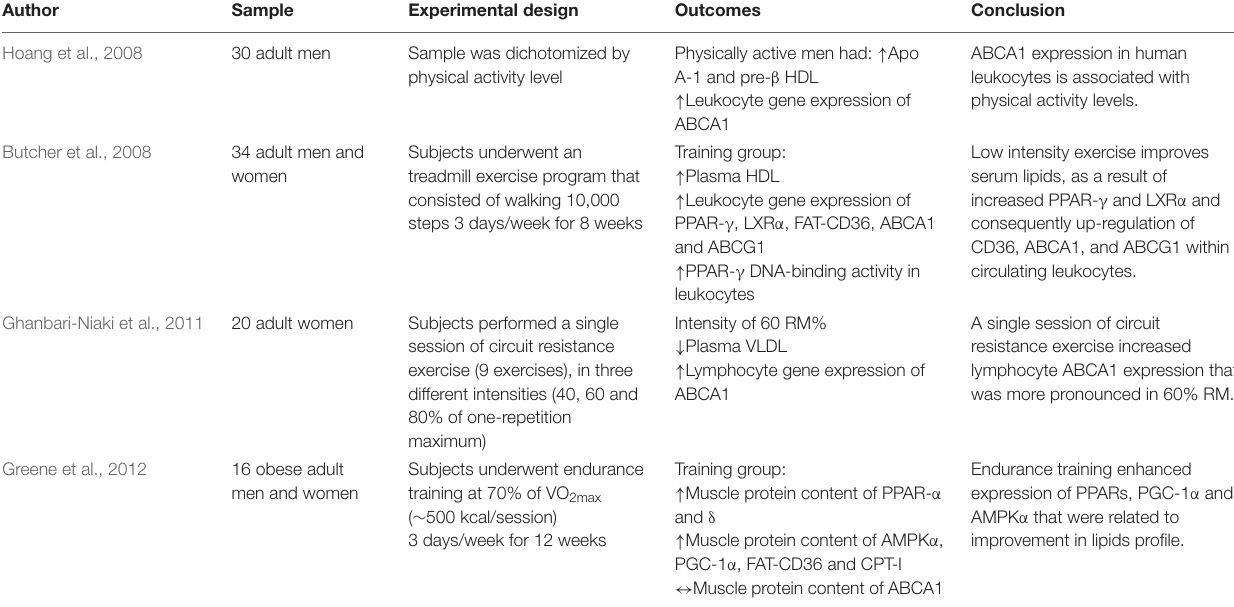
TABLE 3 | Summary of the effects of training strategies on lipids profile and RCT pathway in